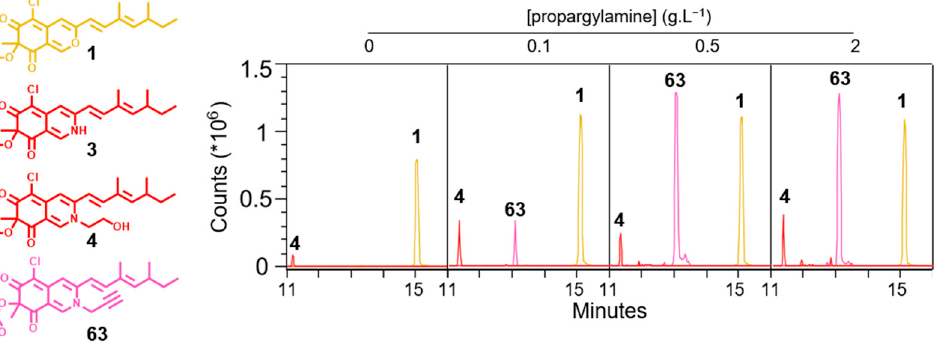
Figure 4. Overproduction of compound 63 by P. sclerotiorum SNB-CN111 with two-step solid state cultivation on porous cellophane membrane. Extracted ion chromatogram of compounds 1 ([M + H] + , m / z 391.1307), 3 ([M + H] + , m / z 390.1467), 4 ([M + H] + , m / z 434.1729) and 63 ([M + H] + , m / z 428.1638) in function of propargylamine concentration added to solid CZK medium.